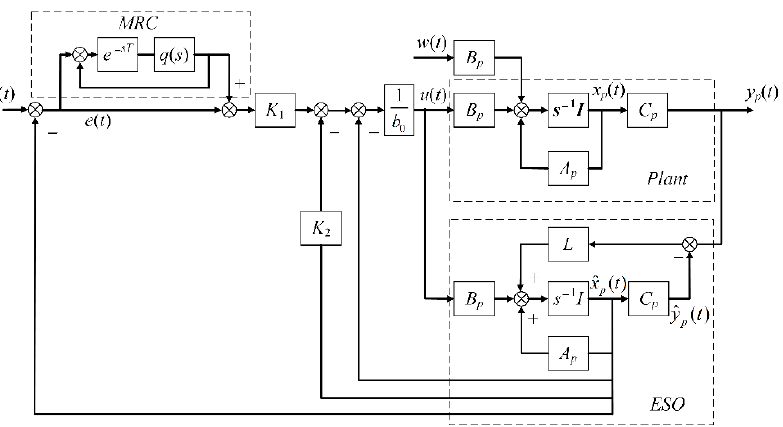
Figure 27. The control block diagram of extended state observer (ESO)-based repetitive control. Reprinted with permission from ref. [116]. Copyright 2017 IEEE.